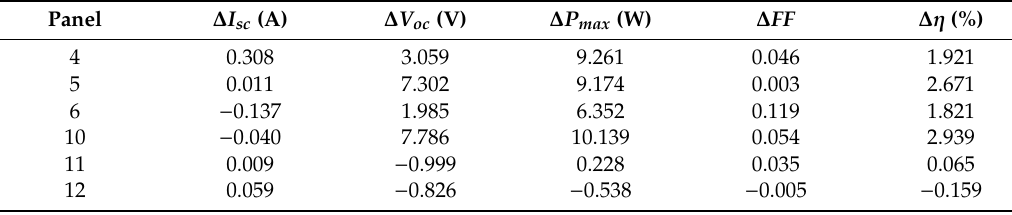
Table 4. Di ff erential values between simulation and measured results for the second test.